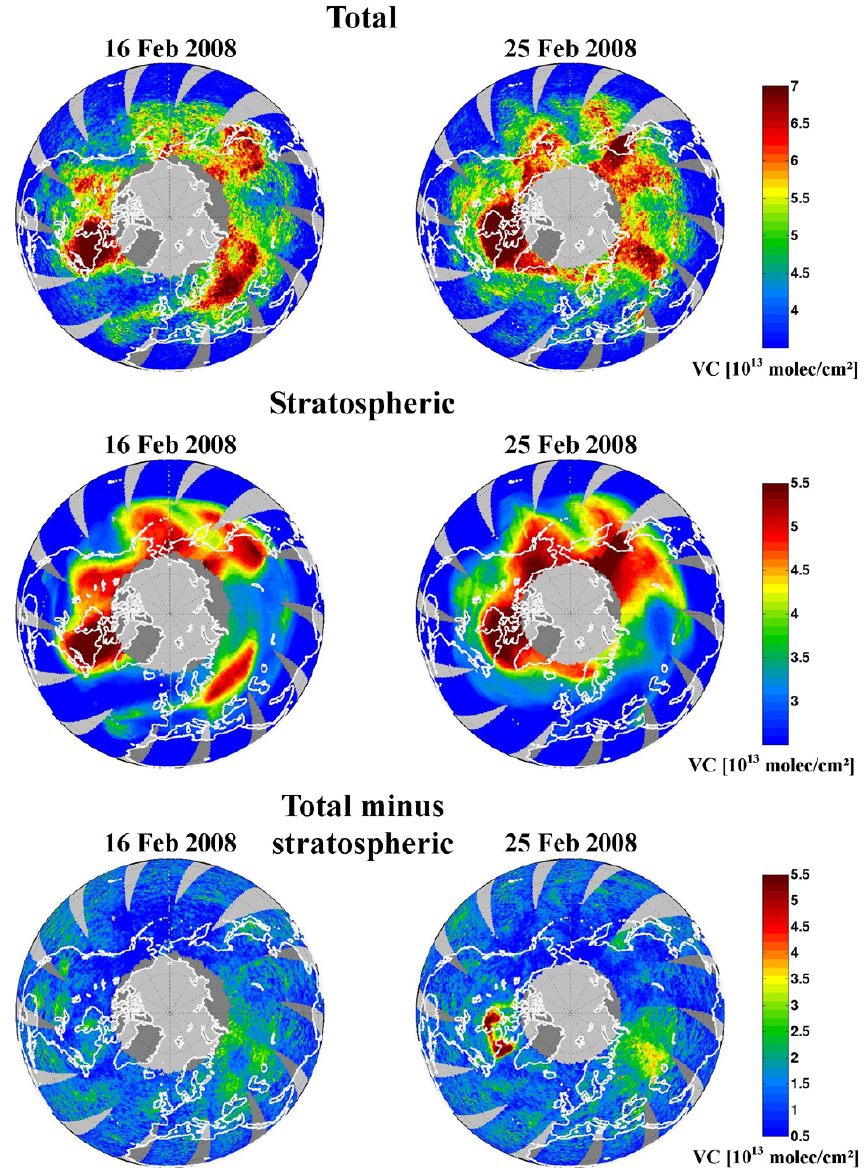
Fig. 9. GOME-2 total BrO columns (upper plots), stratospheric BrO columns calculated from the BASCOE climatology at GOME-2 overpass (center plots) and the difference between the total and stratospheric BrO columns (lower plots). Total BrO columns are estimated using stratospheric air mass factors. The results are presented for the (left) 16 and (right) 25 February 2008. Note that the color scale of the total column maps has been chosen in a way that the correlation with stratospheric BrO structures can be best visualized, although it is not optimal to represent the large range of total BrO column